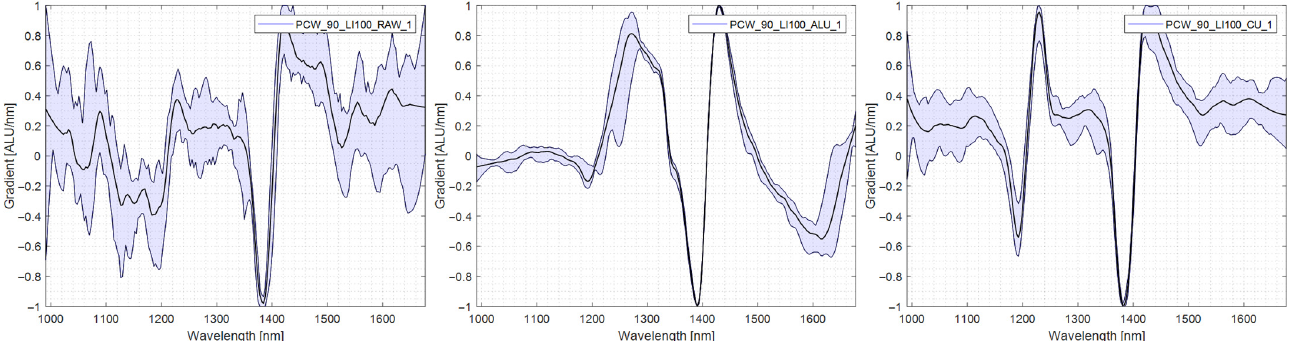
Figure 13. Comparison PE spectra, left : no reflector, middle: aluminium reflector, right : copper reflector.